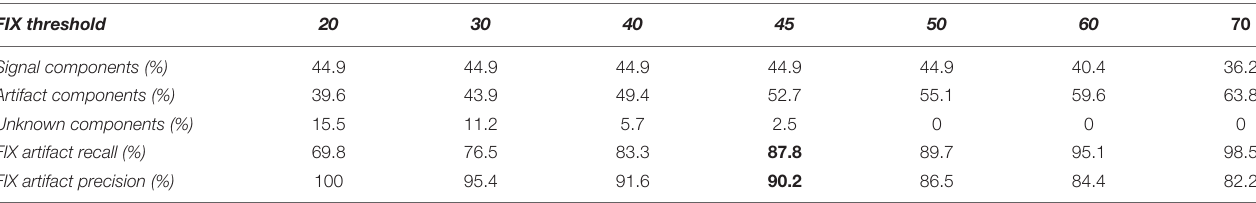
FIGURE 5 | (A) Number of ICs classified as artifacts across all datasets without (blue) and with (red) prior MP-PCA denoising, respectively. MP-PCA denoising substantially reduced artifactual ICA components for most datasets. (B) Prior MP-PCA denoising improved the z -statistic for signal components. Thresholded IC maps in (B) were given by FSL’s MELODIC. TABLE 2 | FIX artifact classification accuracies at different